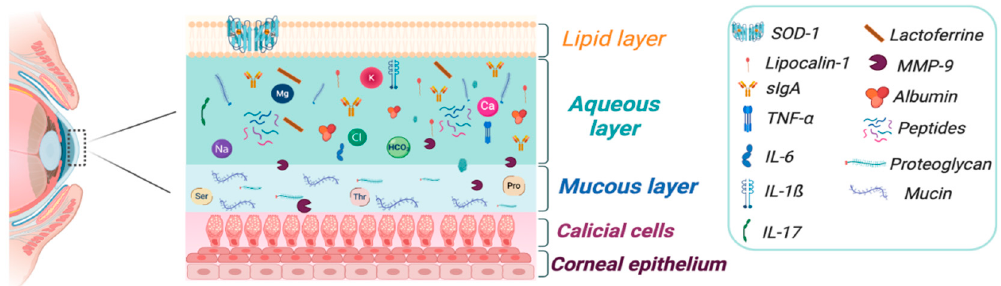
Figure 2. Main components in tear film. The wide variety of components in each layer of the tear film provides function, nutrition, and protection to the ocular surface. However, it is susceptible to change their composition due to oxidative stress and inflammatory processes that involve the eye structures, which makes it an easy access ocular matrix to identify these changes measuring levels of components as biomarkers. SOD1: superoxide dismutase-1, Ser: serine, Thr: Threonine, Pro: Proline, IL: Interleukin, sIgA: surface Immunoglobuline A, MMP-9: matrix metalloproteinase-9, TNF- α : Tumor necrosis factor- α . Image created with BioRender.com.